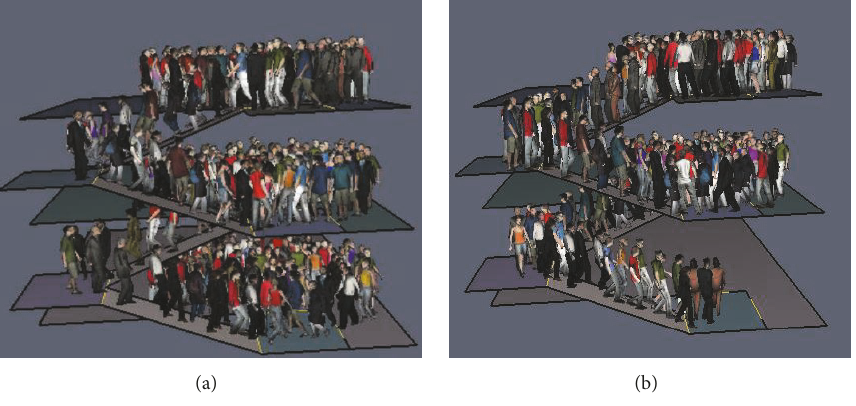
Figure 4: The occupants evacuation status at different time for type3. (a) Occupants evacuation status at 100s; (b) occupants evacuation status at